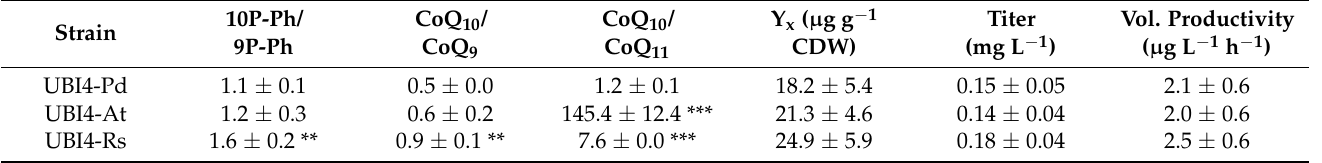
Table 1. Ratios of relative peak areas from mass spectrometry analysis and CoQ 10 biomass yields, titers, and volumetric productivities for the strains UBI4-Pd, UBI4-At, and